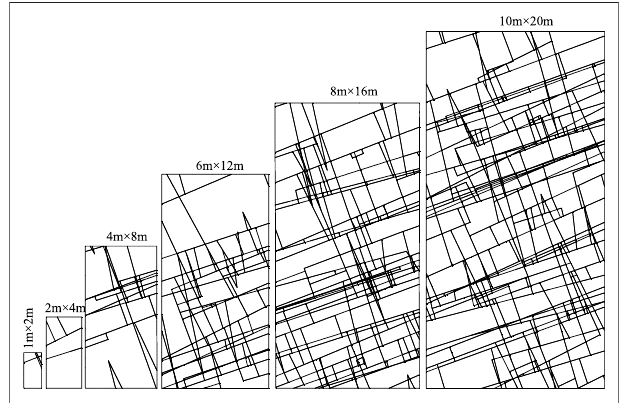
FIGURE 5 | Orthogonal random joint models with different